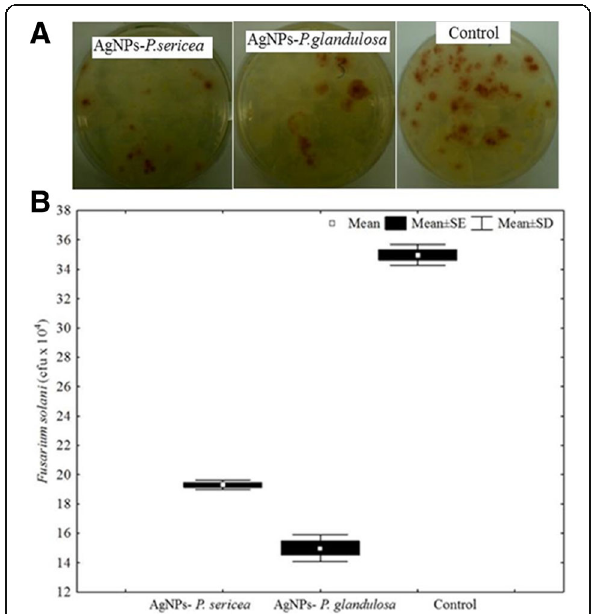
Fig. 1 a Density of fungal propagules after 30 days of exposition to AgNPs from P. sericea and P. glandulosa . b Effects of AgNPs from P. sericea and P. glandulosa on population of Fusarium solani in rhizosphere of cotton plants after 30 days of treatment (values are expressed as mean ± S.D., n =